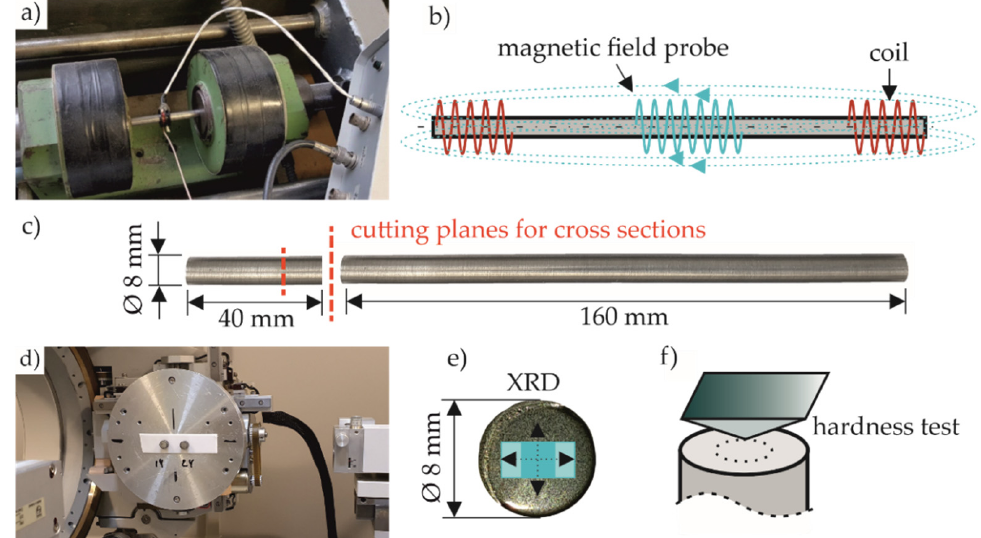
Figure 2. ( a ) Hysteresis frame device and ( b ) schematic illustration of the respective magnetic field in the sample, ( c ) specimen geometry for microstructural investigations and magnetic testing, ( d ) specimens attached to the XRD goniometer, ( e ) cross-section geometry showing the actual XRD spot sizes for phase analysis and the two directions of residual stress measurements, and ( f ) measuring positions of hardness tests.